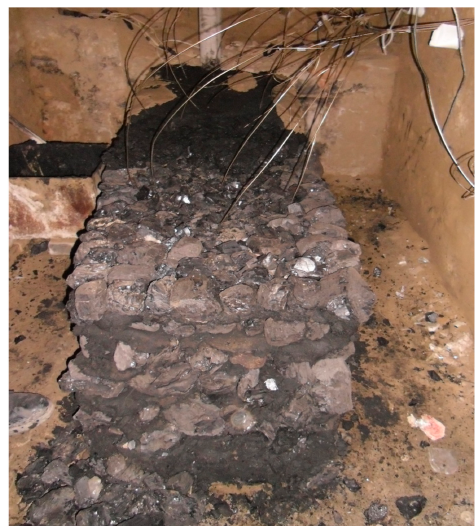
Figure 3. Coal seam in the test.